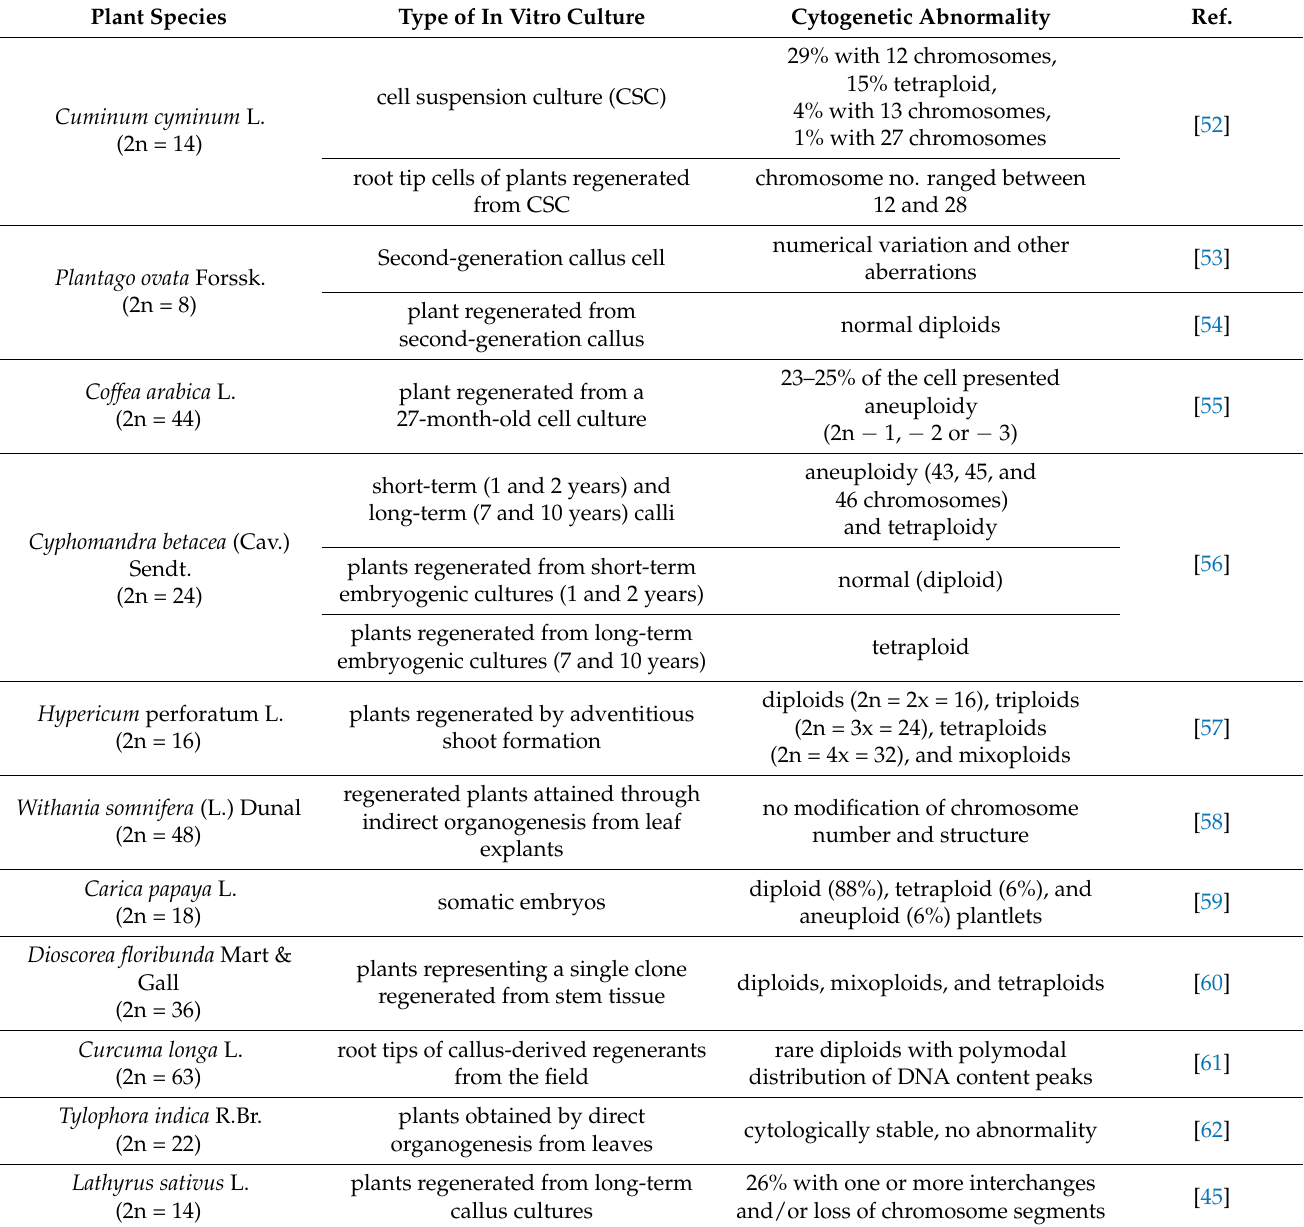
Table 1. Cytogenetic abnormalities in micropropagated medicinal